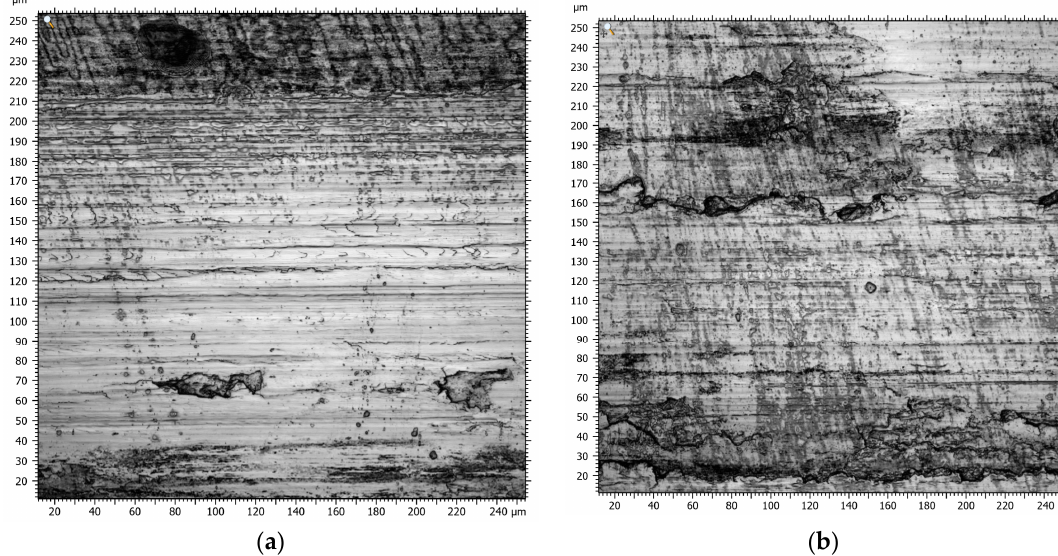
Figure 12. Surface produced with a hard-coated tool before ( a ) and after ( b ) tool failure.